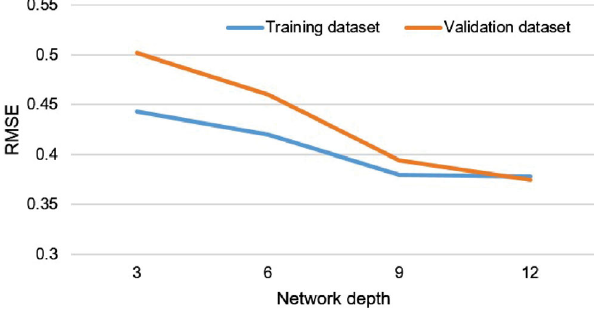
Fig. 9 Performance of CNN models with different network depths (numbers of convolutional